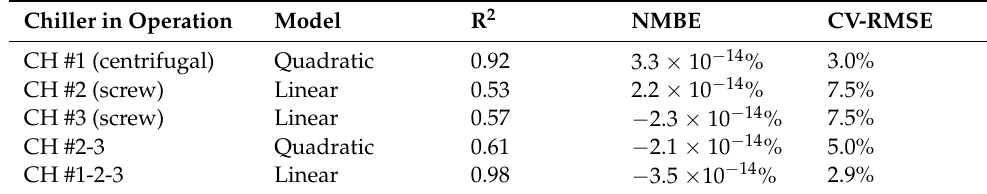
Table 1. Accuracy of chilled water system COP models.